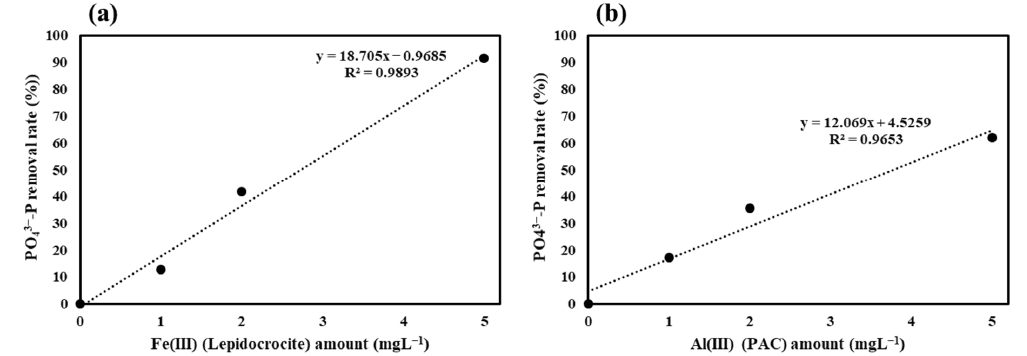
Figure 4. T-P-removal efficiency using L-Fe dissolved solution with different normality; ( a ) L-Fe dissolved solutions with HCl mixing, ( b ) L-Fe dissolved solutions with H 2 SO 4 mixing. Experimental conditions: [PO 43 − -P] 0 = 10 mg · L − 1 , [Fe 3+ solution] 0 = 3 mg · L − 1 . ( c ) T-P removal efficiency and variation of final pH in different pH solutions.